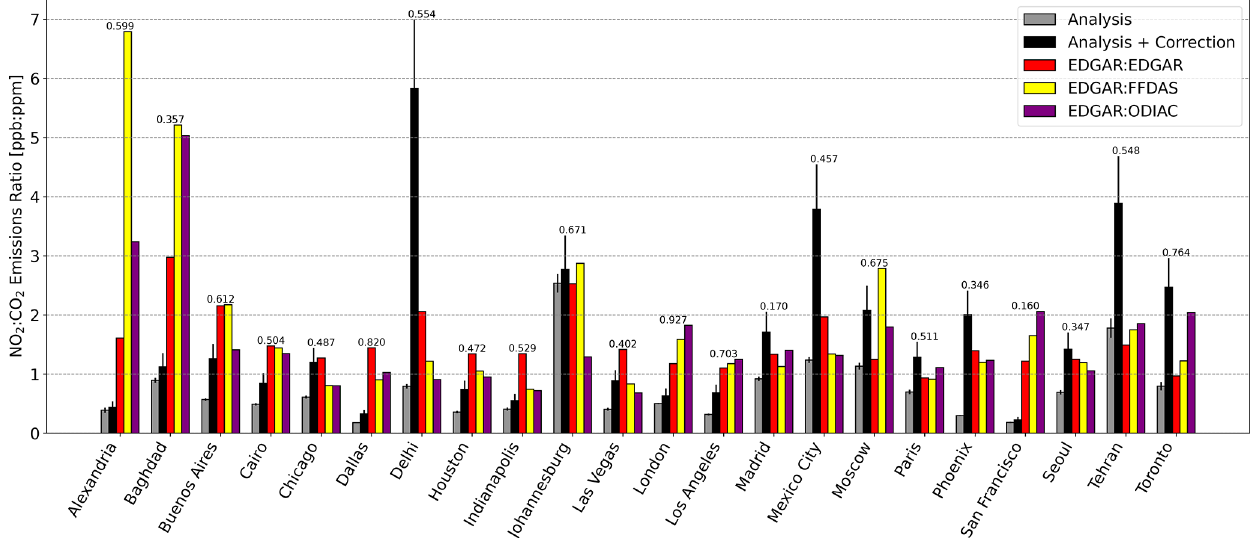
Figure 7. Same as in Fig. 6 but for NO 2 : CO 2 ratios derived using OCO-2/3 and TROPOMI observations. NO 2 enhancements calculated without a lifetime correction are in grey and labelled “analysis”, and those with a lifetime correction are in black and labelled “analy- sis +